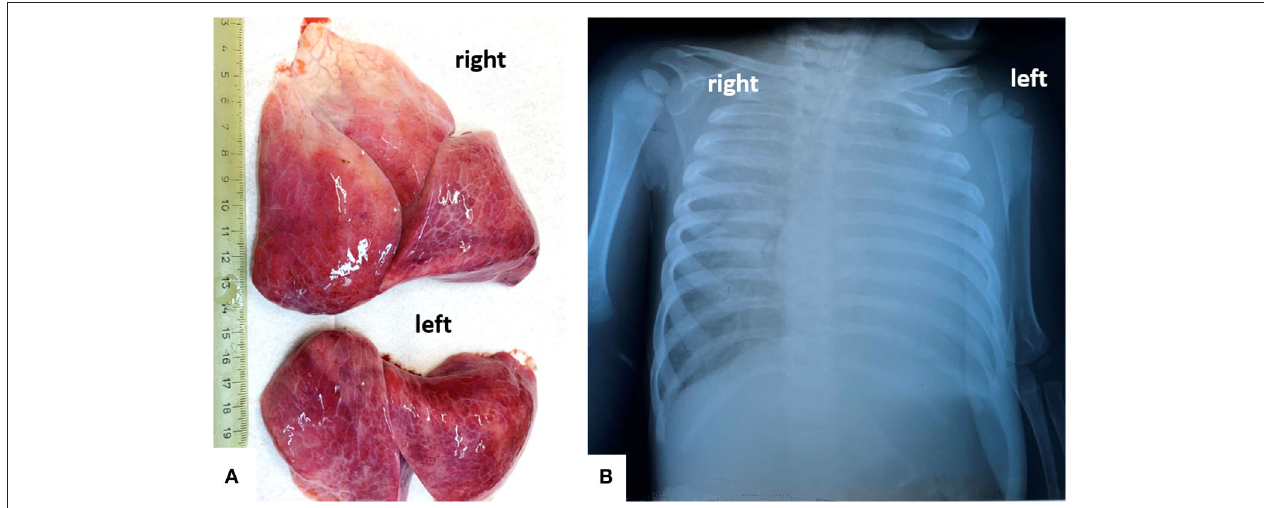
FIGURE 1 | In a 13-months old girls, bilateral severe pulmonary dystelectasis, revealed by post-mortem examination (A) , correspond to the Rx-image, which shows ground-glass opacities, in the right lung, and diffuse opacity of the left lung (B) .